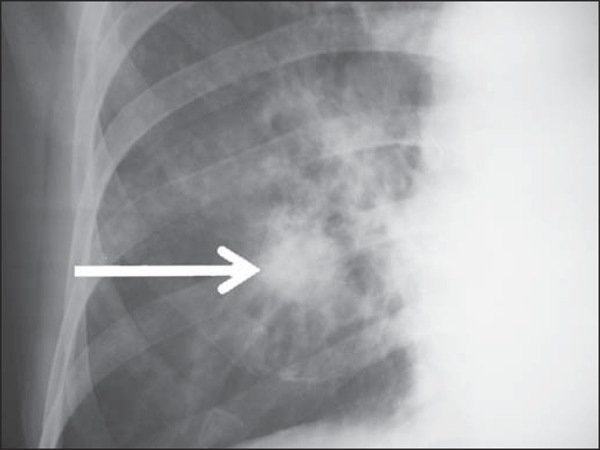
A 47-year-old man with a nodule (arrow) in the right lung.